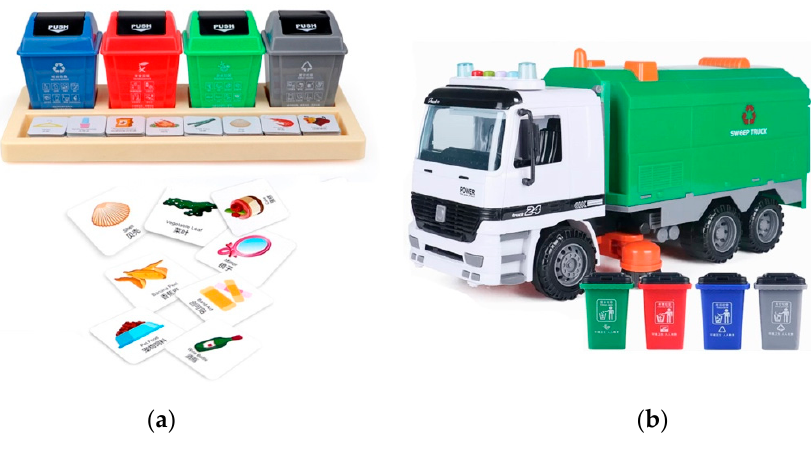
Figure 1. ( a ) Card game and ( b ) garbage truck